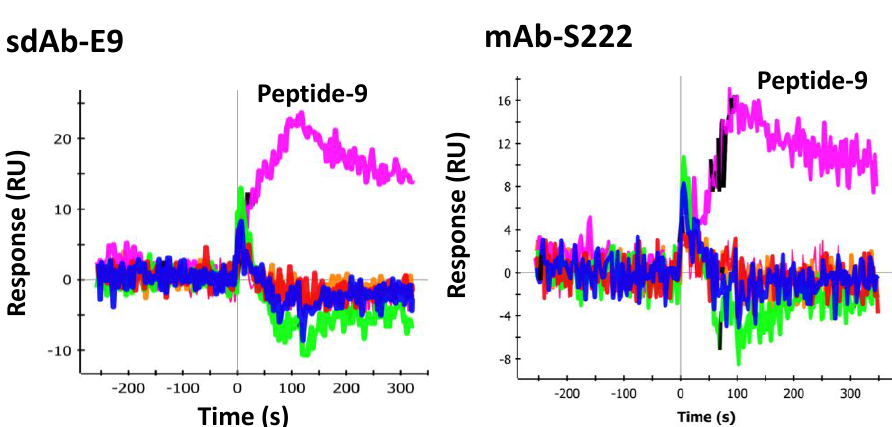
Figure 6. SPR of peptide fragments of SEB for epitope mapping.